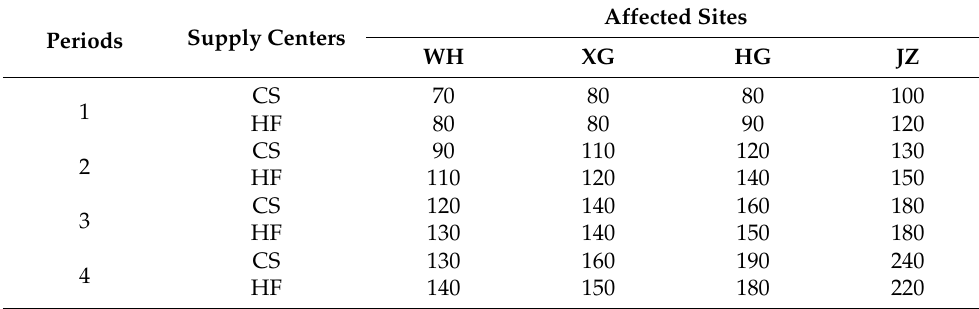
Table 7. Maximum transportable amount of emergency materials from supply centers to affected sites in each time period (m 3